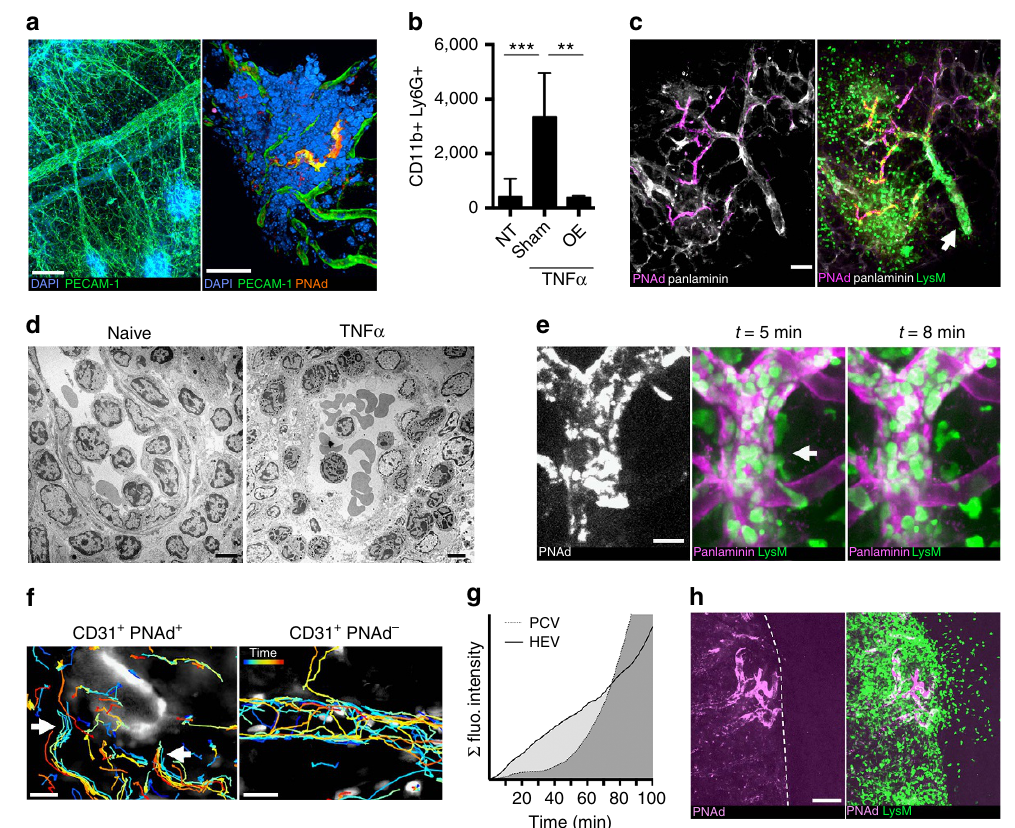
Figure 1 | HEVs of the greater omentum enable rapid neutrophil exit in TNF a -peritonitis. ( a ) Confocal micrographs of the naive omentum show vascularization and milky spots (left panel). PNAd þ PECAM-1 þ -HEVs are distinct vascular compartments within the milky spot (right panel). Scale bars, 120 m m (left) and 40 m m (right). ( b ) Non-treated (NT), omentectomized (OE) or sham-operated mice were compared by analysing the peritoneal lavage after 60min i.p. treatment with TNF a . Cell number as mean ± s.d. n ¼ 5 per condition of three independent experiments. Student’s t -test ** P o